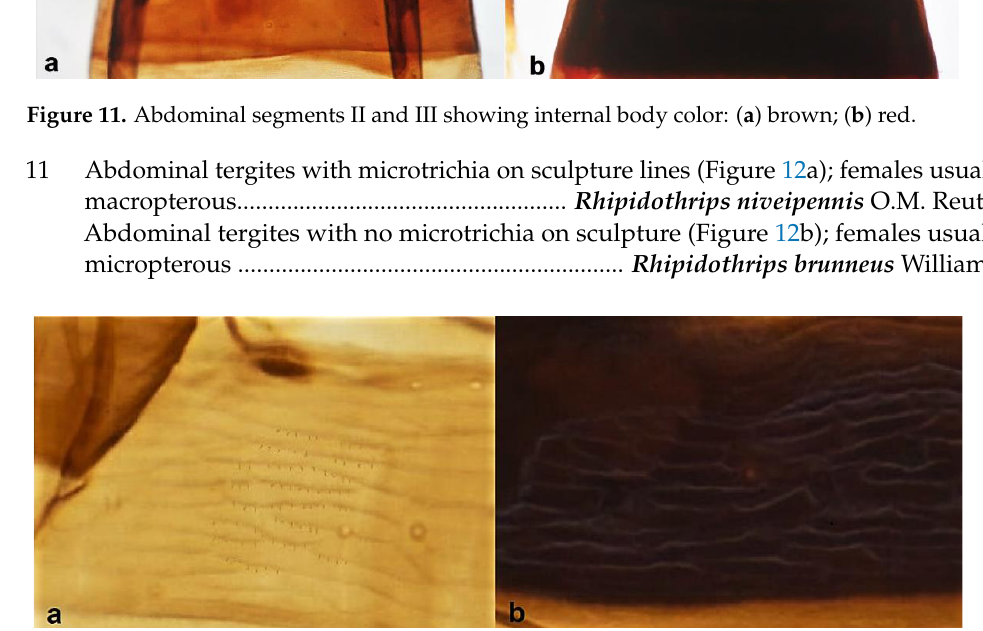
Figure 12. Section of abdominal tergites: ( a ) with microtrichia on sculpture; ( b ) with no microtrichia on sculpture. Fore wing evenly brown, not banded (Figure 13b) and with a small pale sub-basal